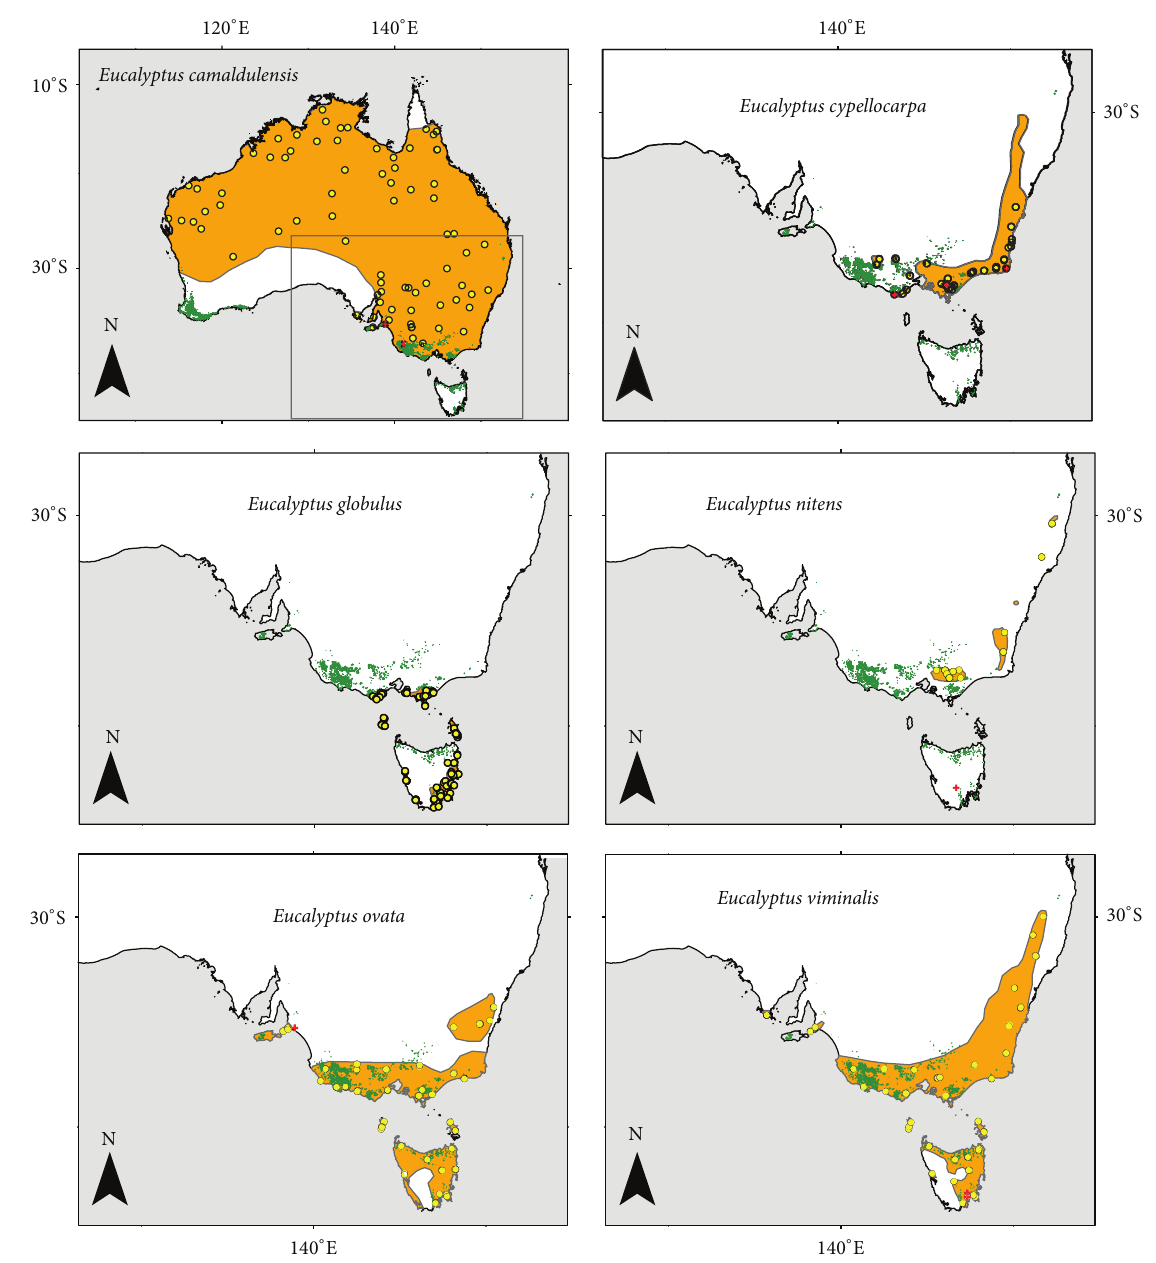
Figure 1: The natural distributions (in orange) of Eucalyptus camaldulensis , E. cypellocarpa , E. globulus , E. nitens, E. ovata , and E. viminalis , with the distribution of samples used (yellow circles), the hybrids used (red crosses), and of E. globulus plantations (green polygons). The box within the E. camaldulensis map shows the extent of the maps for the other species (species distributions reproduced from [12,